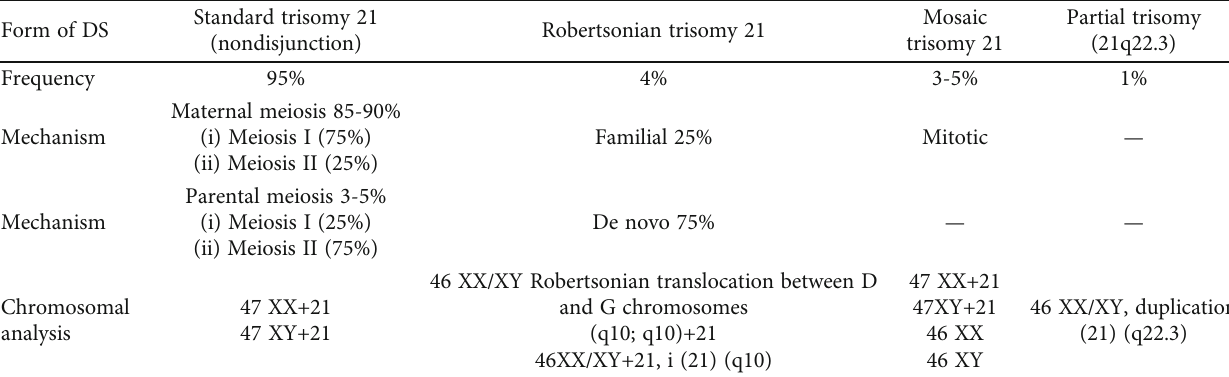
Table 1: Di ff erent origins of Down syndrome (trisomy